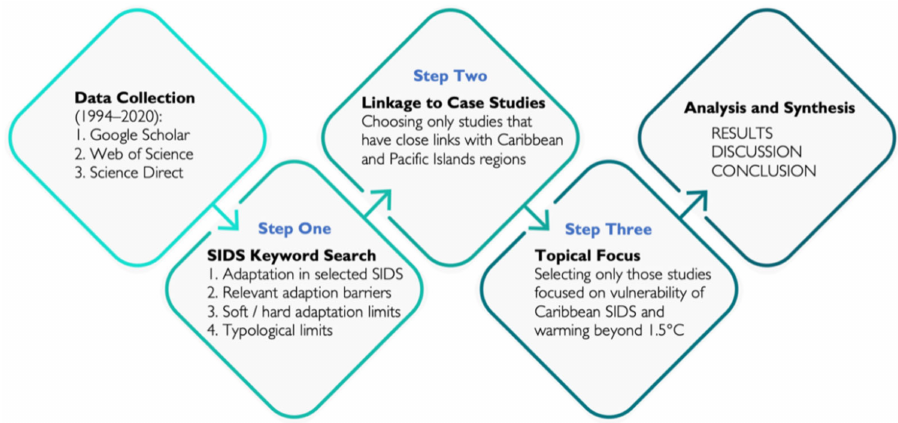
Figure 3. In-depth research process reflecting the main steps of data collection and